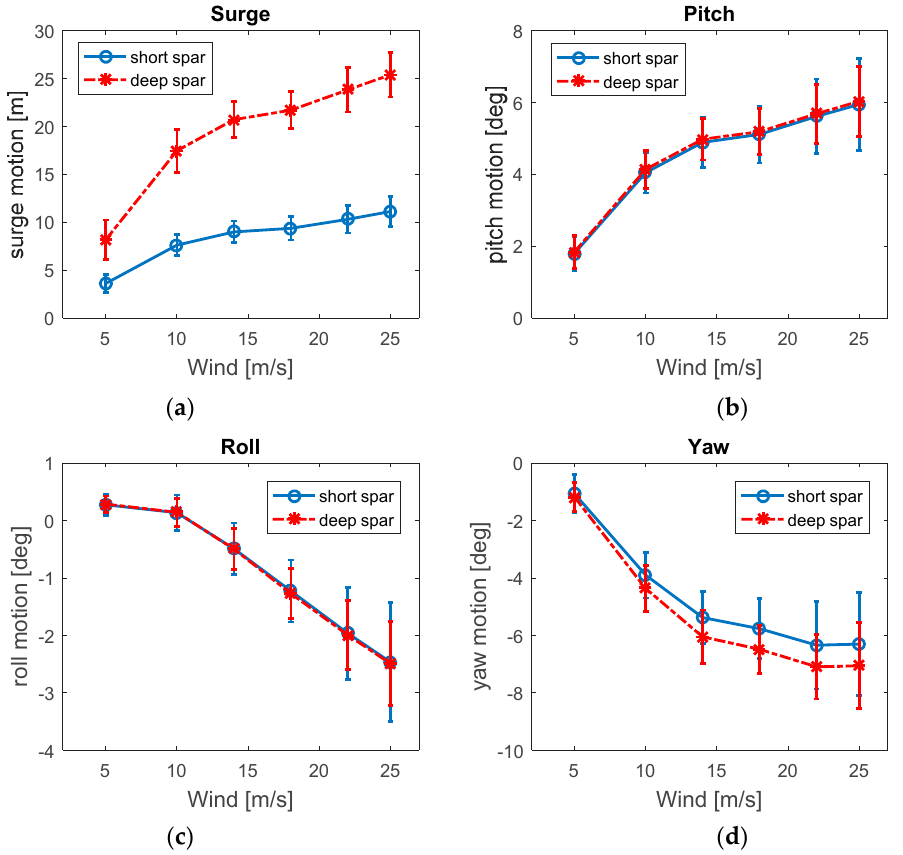
Figure 9. Comparison of mean values with error bar indicating the standard deviation in surge, heave, roll, and yaw motions for the short and deep spar VAWT: ( a ) Surge; ( b ) Pitch; ( c ) Roll; ( d ) Yaw.